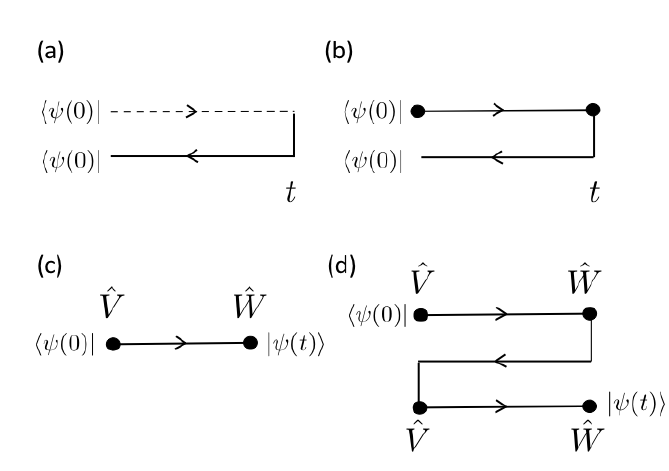
Figure 12 . (a) Loschmidt echo. The dashed line is a time evolution to time t by the Hamiltonian H ′ , while the solid line is that by the Hamiltonian H . (b) Loschmidt echo, to the second order in perturbation of H ′ the dashed line in (a). We depict the case when the perturbations are at both ends, t = 0 and t . (c) A time-order correlator,